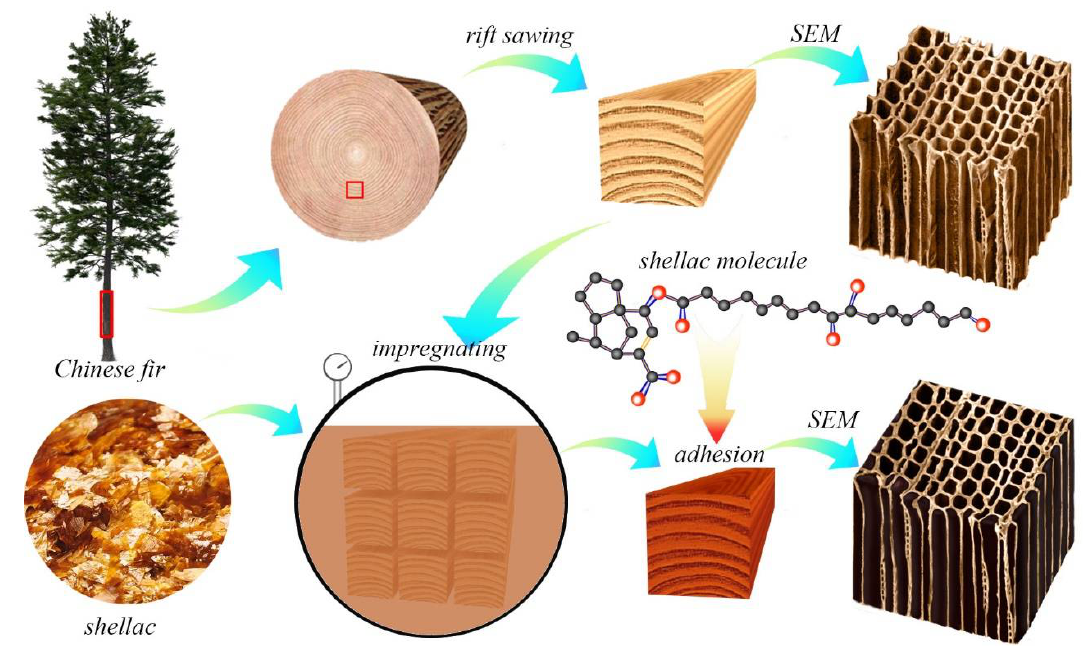
Figure 1. Schematic of the impregnation with shellac polymer.